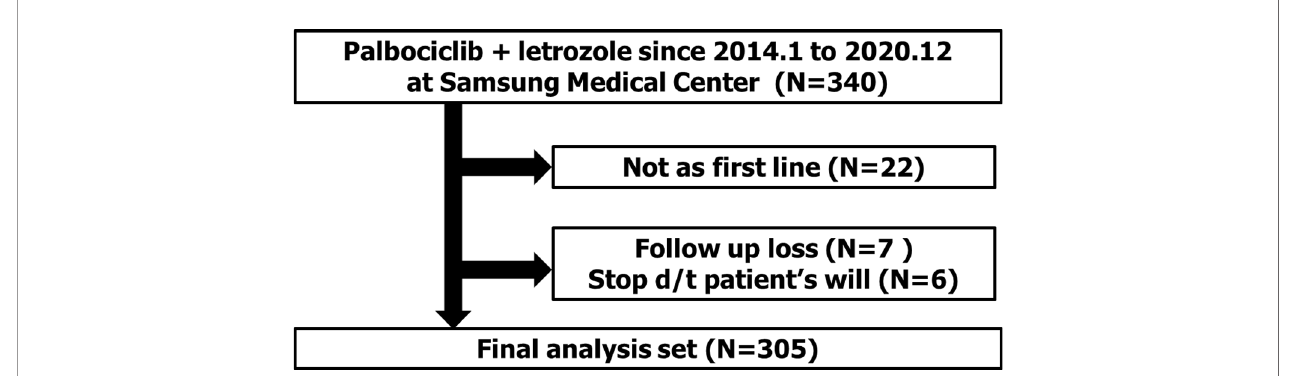
FIGURE 1 | Consort